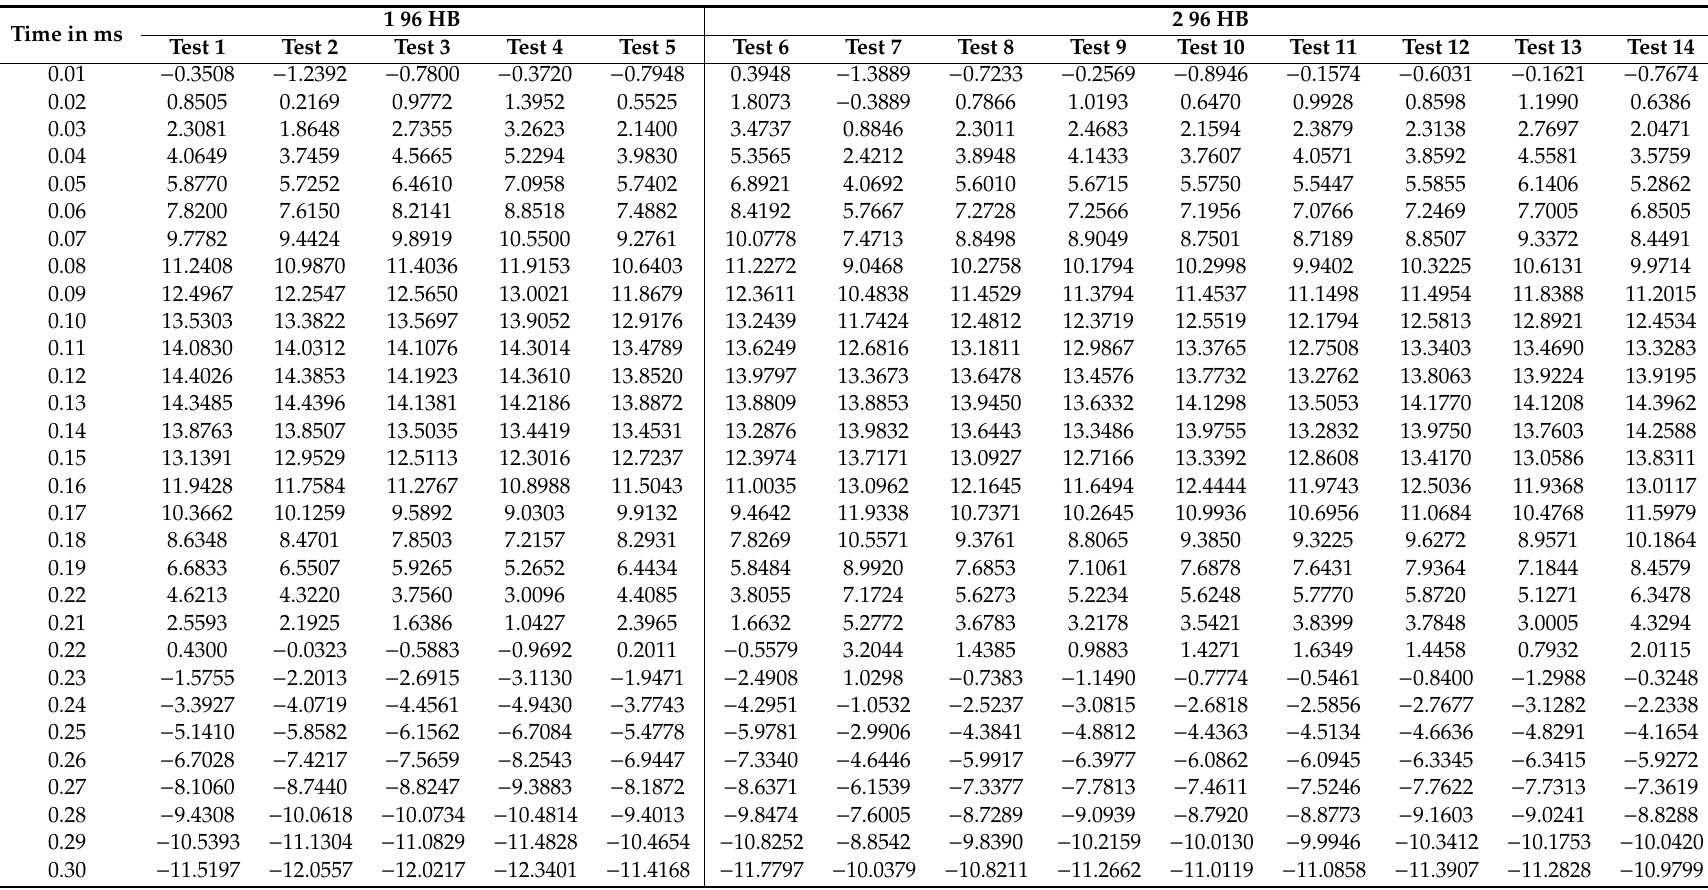
Table A1. Accelerations measured for tests from 1 to